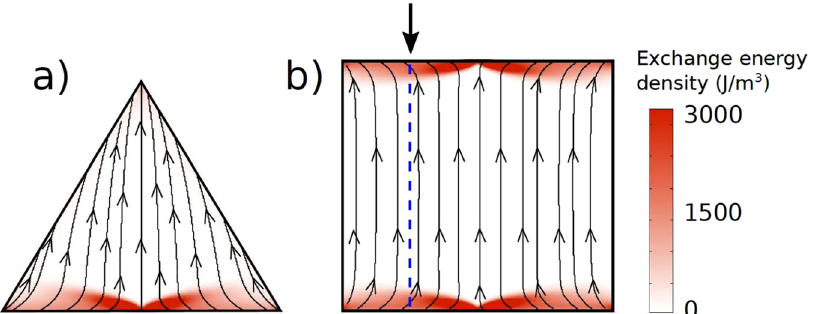
Figure 2. ( a ) Triangular and ( b ) square dot under an applied field of 1000 Oe, perpendicular to one of the faces. The lateral size is 2 μ m and the thickness is 30 nm . The black streamlines and arrows represent the magnetization distribution. The color scale represents the exchange energy density. The dashed blue line is mentioned in Fig. 3.